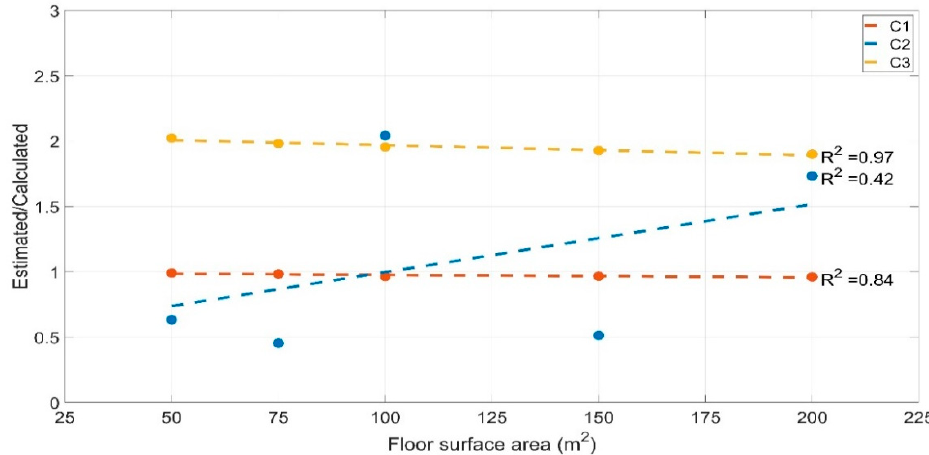
Figure 11. Estimated/calculated ratio of capacitances for different FS values in x-2-15-0 heavy- structured